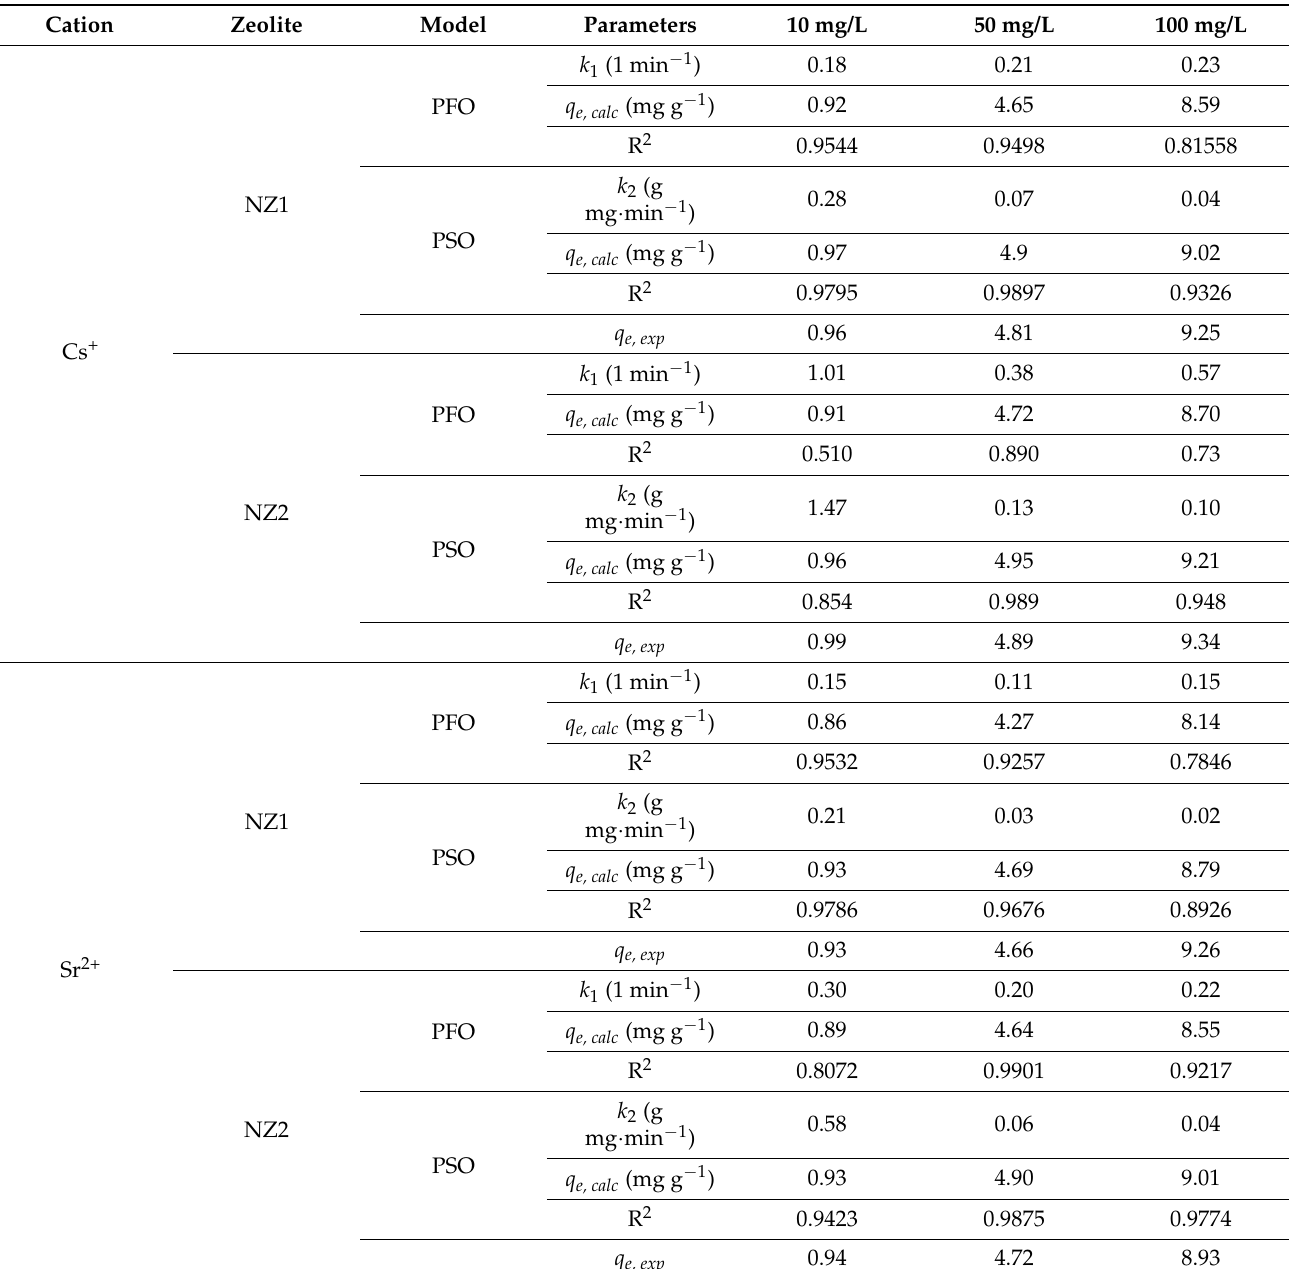
Table 4. Kinetic parameters for Cs + and Sr 2+ sorption on NZ1 and NZ2 at different initial concentra-